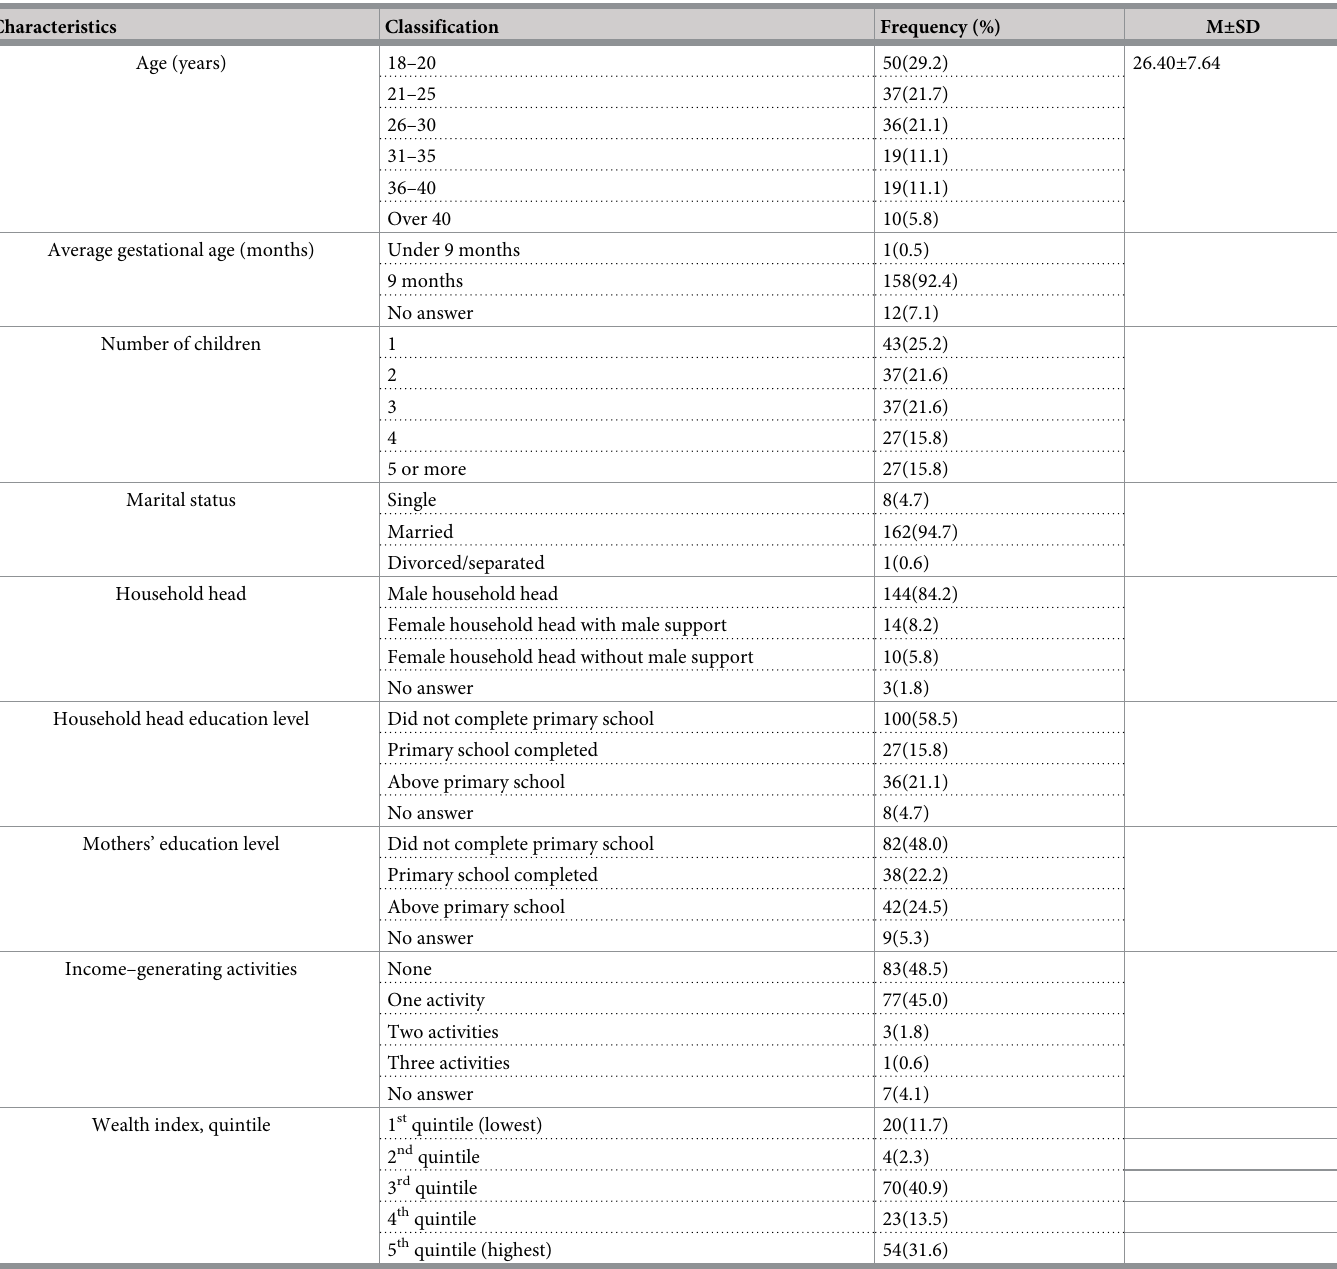
Table 1. Demographic characteristics of subjects (N =